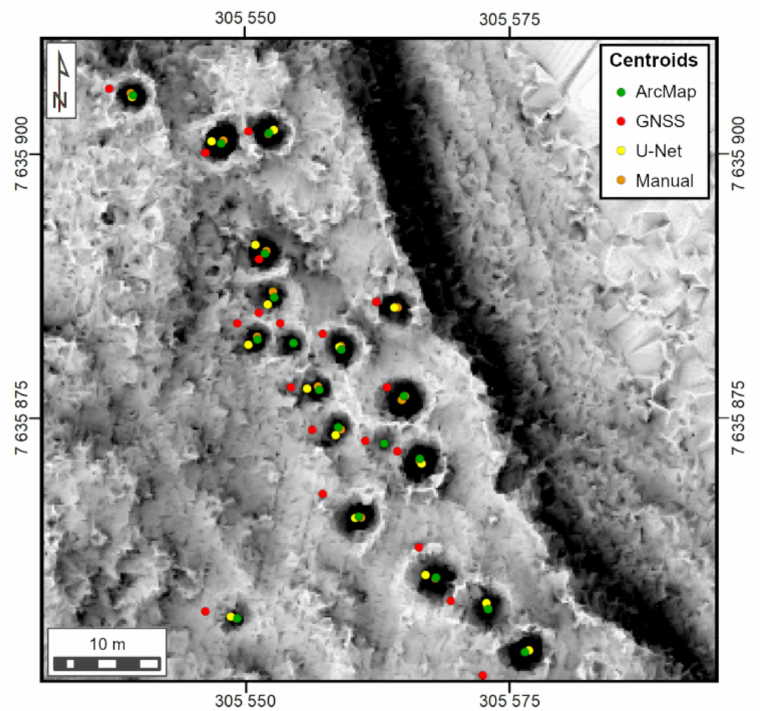
Figure 10. Example of the comparison between the manually digitized positioning data for pitfall traps at Mohkkeguoika and the centroids acquired using the three observer independent methods (SVF visualization). (EPSG:3879 ETRS89/GK25FIN). (Illustration: Janne